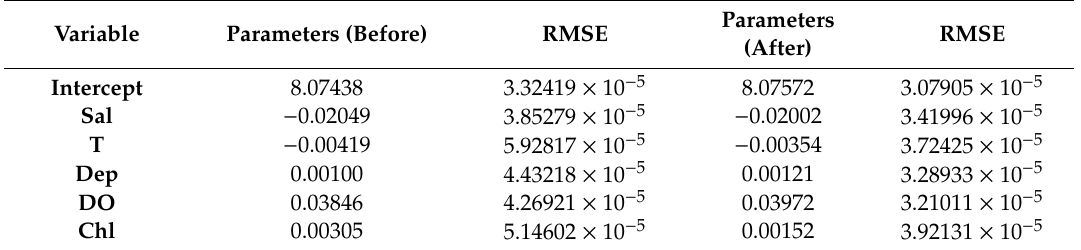
Table 1. Coe ffi cients and root mean squared error (RMSE) of multiple linear regression (MLR).